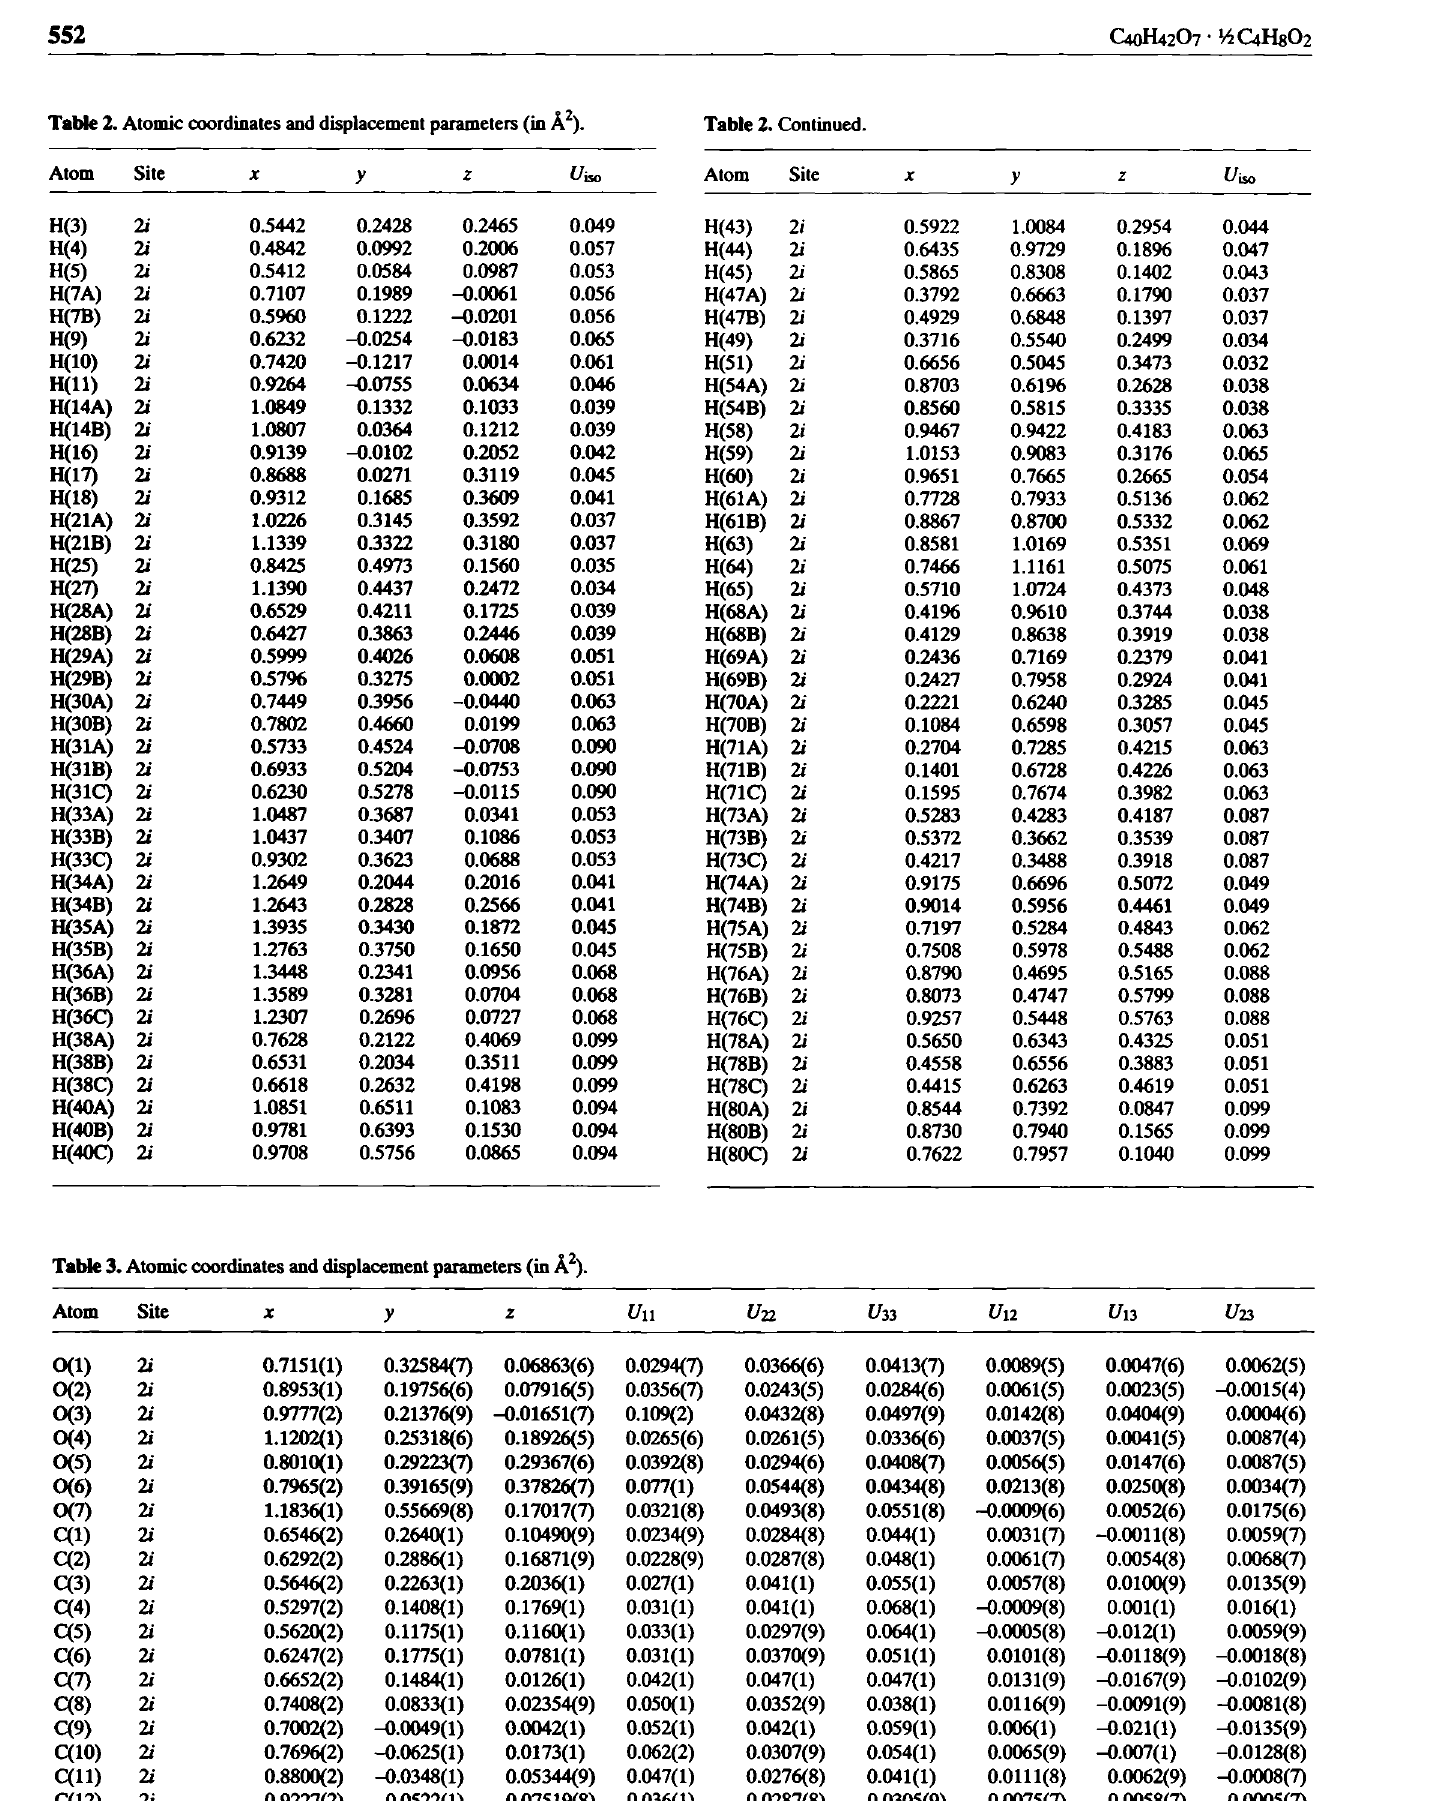
Table 3. Atomic coordinates and displacement parameters (in Ä 2